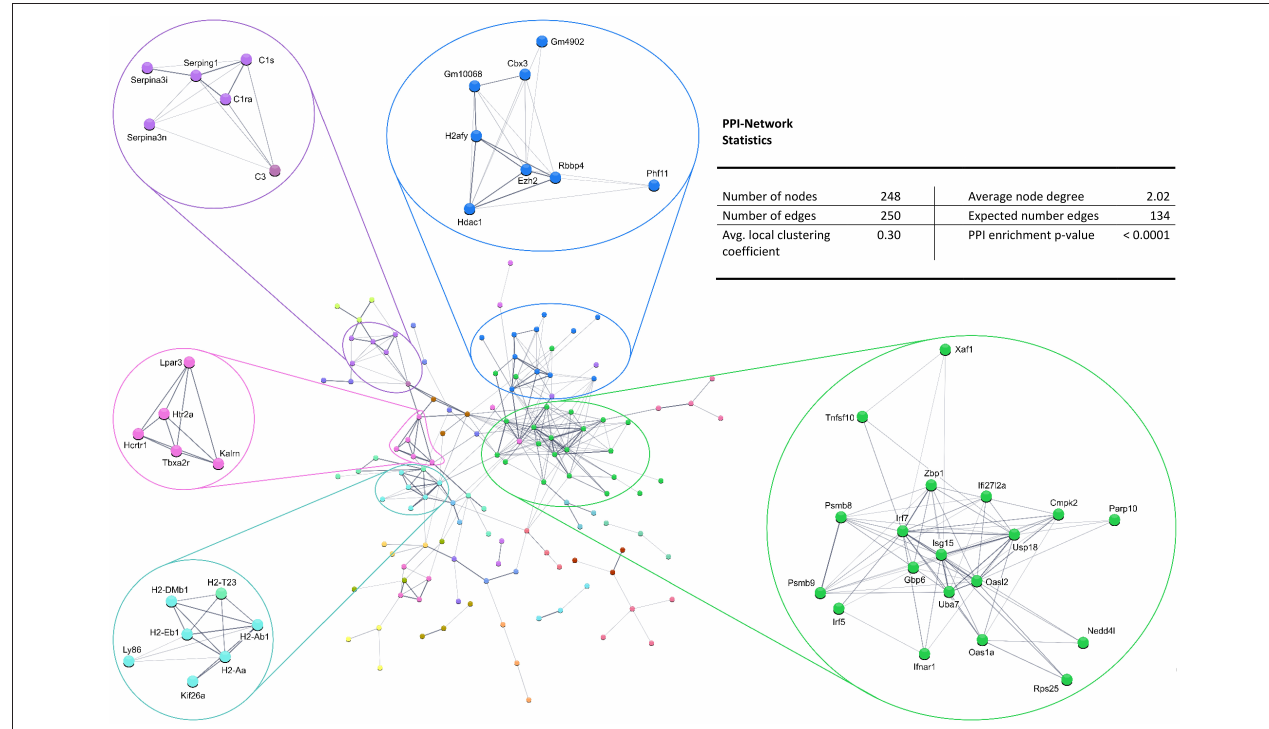
FIGURE 4 | STRING database protein–protein interaction (PPI) network of significantly downregulated genes. Cut-off values, p ≤ 0.01, fold change ≥